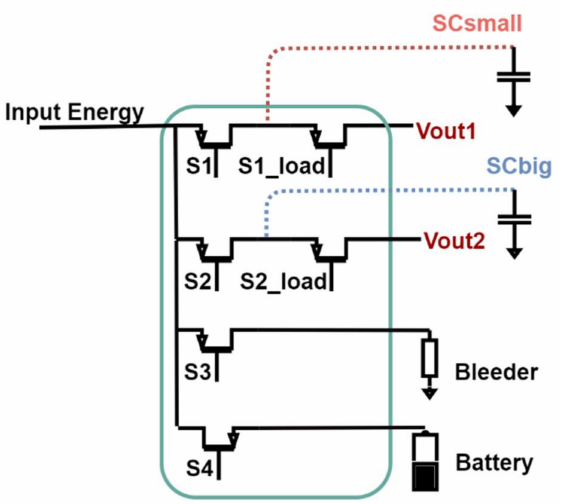
Figure 2. The topology of the proposed energy storage